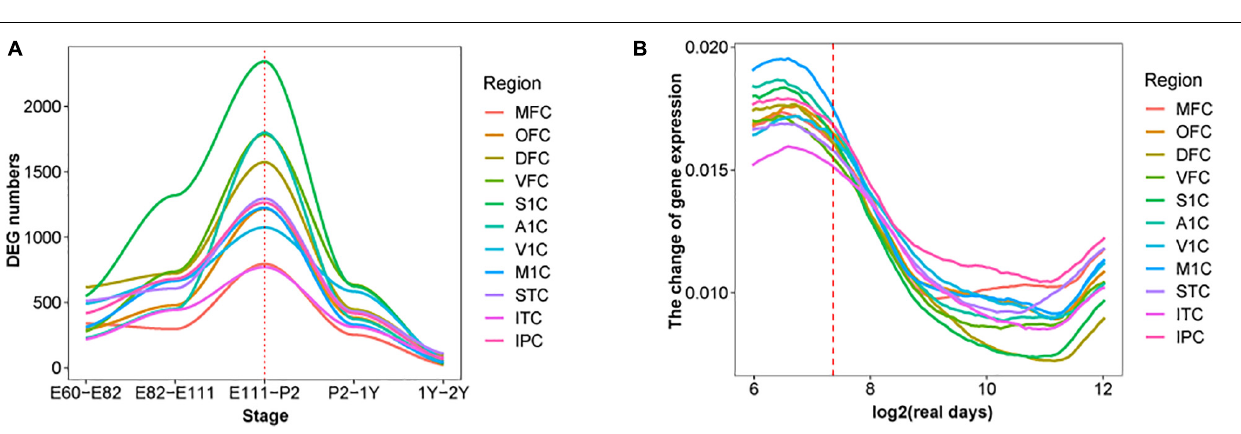
FIGURE 1 | Similarity between early developmental transcriptome of macaque and human brains. (A,B) PCA plot of 179 rhesus macaque brain samples, with each dot representing a sample. (C,D) PCA plot of 147 human brain samples, with each dot representing a sample. (A,C) The developmental period was used to mark the samples. (B,D) The different brain regions were used to mark the samples. (E) Number of differentially expressed genes (DEG) in rhesus macaques detected at adjacent time periods, the x -axis represents the time period, the y -axis is the number of DEGs. (F) Number of DEGs in human detected at adjacent time periods, the x -axis represents the time period, the y -axis is the number of DEGs, * denotes the peak, and the different colors represent the segmentation before and after birth. (G) The number of DEGs overlapping at peak period between human and rhesus macaques. (H) GO enrichment analysis of overlapping DEGs, sorted from smallest to largest by p -value. Smaller p -values are indicated by darker red color. The size of the circle represents the number of DEGs and x -axis represents the odd ratio.